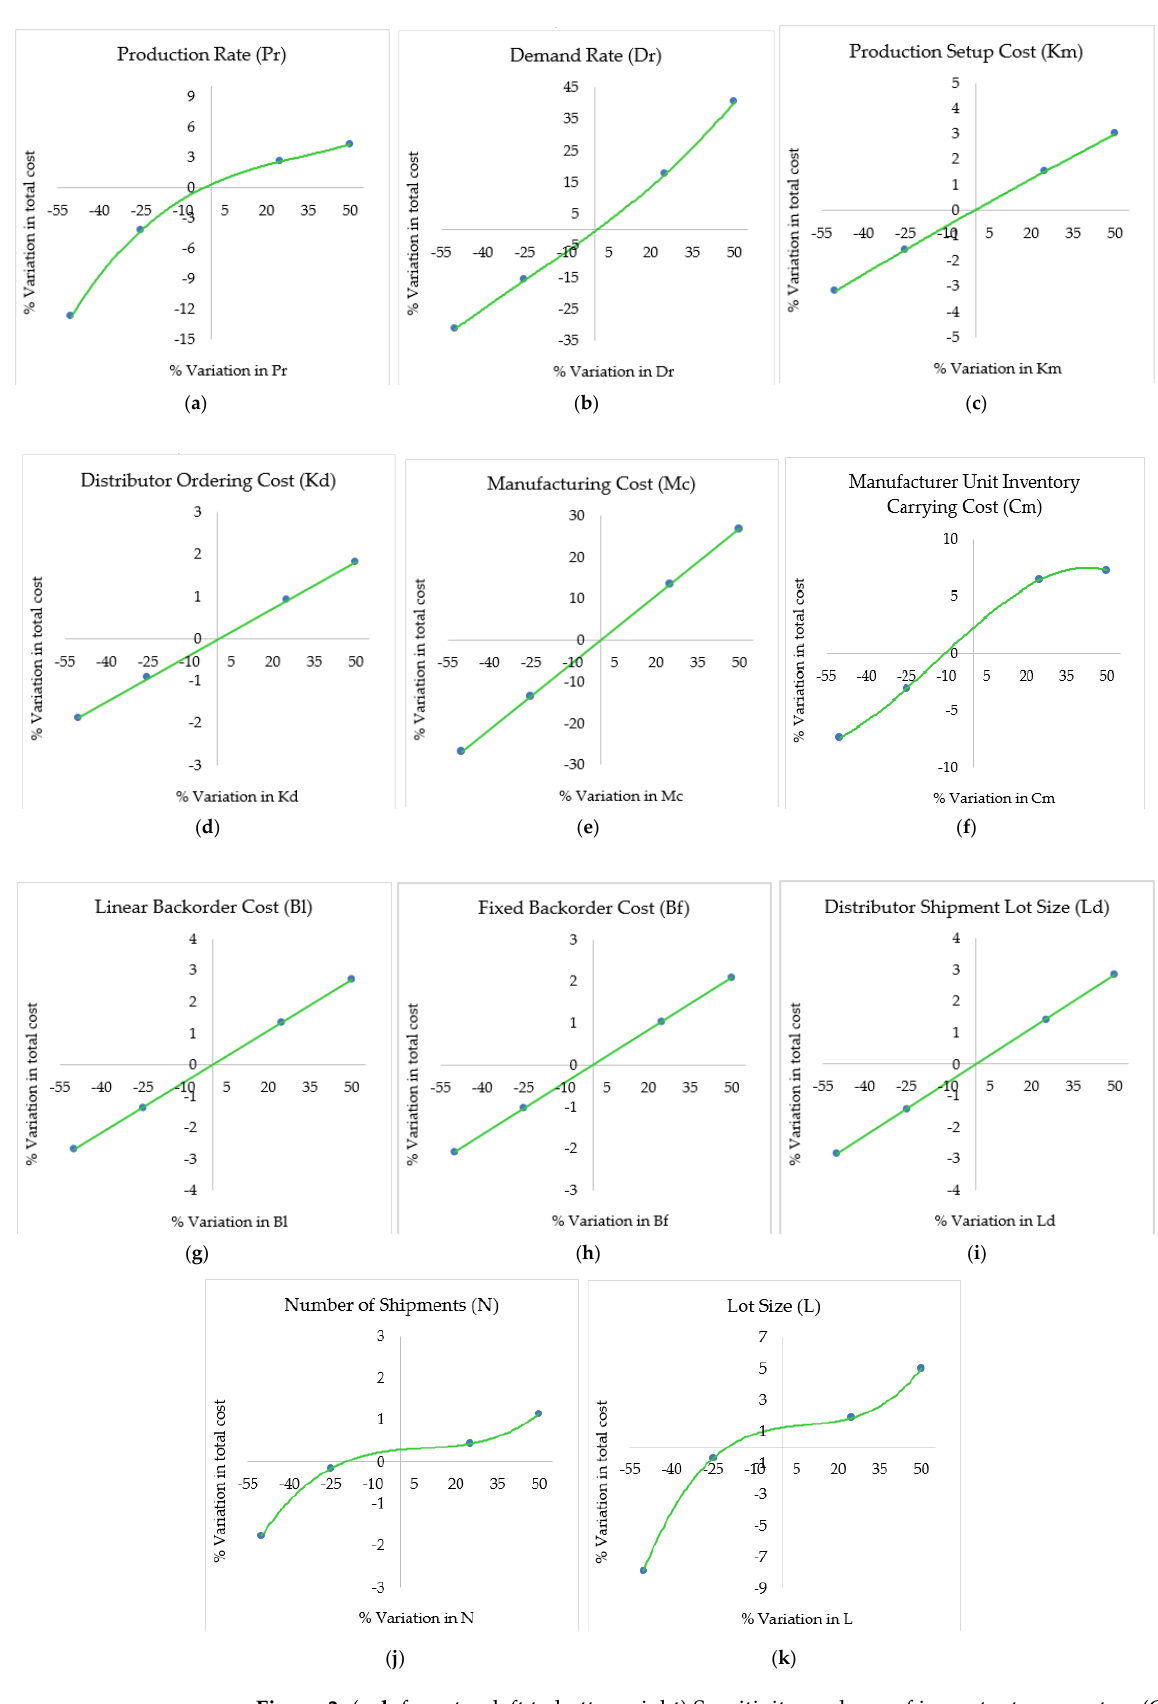
Figure 3. ( a – k from top left to bottom right) Sensitivity analyses of important parameters (Case 1). Figure 3c shows the affiliation of the production setup cost with the total system ’ s cost. From the numerical figures, this parameter seems to be non-sensitive as the % vari- ation in the total cost remains around 1.5% when increasing or decreasing the % of the setup cost value by 50%. Figure 3d illustrates the distributor ordering cost and retailer ordering cost. From the obtained figures, it is evident that these parameters are also very sensitive to the overall system’s cost . In both types of ordering costs, the variation in sys- tem cost is reduced by about 1.8% only by increasing or decreasing the value of ordering cost either by 25% or 50%. As shown in Figure 3e, there is a linear relationship between the manufacturing production setup cost and the total cost. This parameter shows that the total system cost, which is the most sensitive, is reduced up to 26% when the machining cost is reduced up to 50%. As shown in Figure 3f, the manufacturer inventory carrying costs also aff ect the total system’s cost appreciably, by a value up to 7.8% when % of the manufacturing inventory holding cost is reduced to 50%. As compared to this, the re- tailer ’s inventory holding cost shows a minimum effect of 0.3% only for the total system’s cost reduction when the retailer’s inventory is reduced up to 50%. Figure 3g,h portray the linear and fixed backorder costs, respectively. Both costs show a similar linear trend, and the overall system’s cost is reduced by 2.7 and 2% , re- spectively, when the backorders are reduced up to 50%. Figure 3i illustrates the distribu- tor’s lot size effect on the system cost. Both show a similar linear trend and a reduction in the system cost by about 2.84% when the lot size is increased by 50%. As depicted in Fig- ure 3j, there is an interesting relationship between the system cost and several shipments. Increasing the value of a few shipments by 50% increases the total cost of the system by 1.15%, while its value is decreased by 1.77% of its original value when the shipments are decreased by 50%. As shown in Figure 3k, there is a direct nonlinear relationship between the shipment lot size and the total cost of the overall system. By increasing or decreasing the shipment lot size, the total cost of the system is changed variably. Increasing the lot size value by 50% results in a 5% increase in the system cost, while it is reduced by 7.86% when the lot size value is reduced to 50%. 4.2. Numerical Example for Case 2 A manufacturer produces 550 items per year. The yearly demand placed by custom- ers is 300 units. From the previous year’s record, it is known that the manufacturer inven- tory carrying cost per product per unit of time is USD 50, and the retailer inventory car- rying cost per product per unit of time is USD 5. The distributor inventory carrying cost per product per unit of time is USD 5, the linear backorder cost per product per unit of time is USD 10, the fixed backorder cost per product is USD 1, the manufacturing cost of